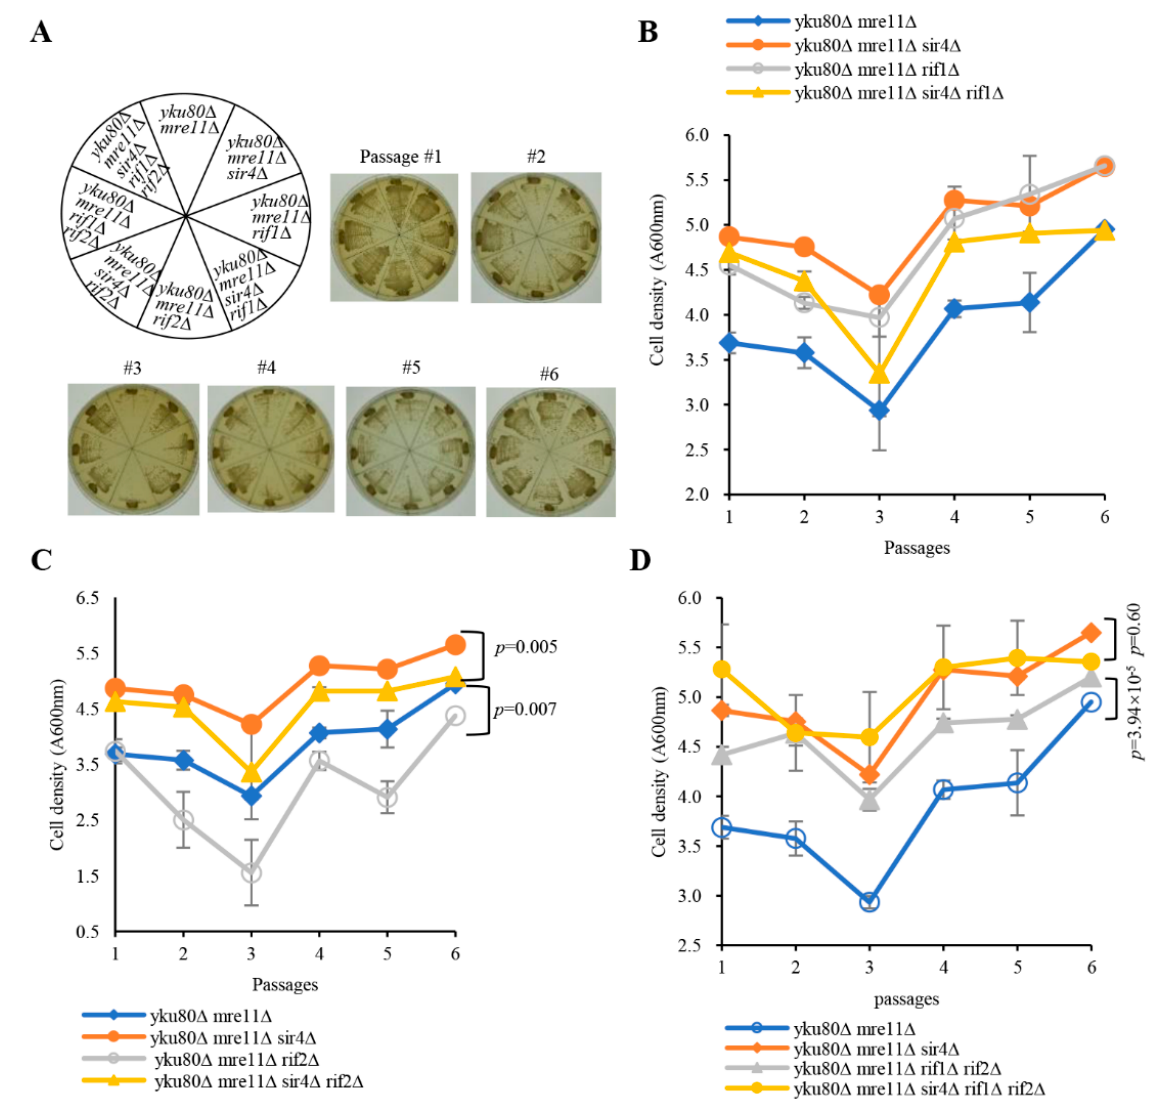
Figure 2. Effects of single and double deletions of RIF1 and RIF2 on the senescence of yku80 ∆ mre11 ∆ and yku80 ∆ mre11 ∆ sir4 ∆ cells. ( A ) Spore yku80 ∆ mre11 ∆ , yku80 ∆ mre11 ∆ sir4 ∆ , yku80 ∆ mre11 ∆ rif1 ∆ , yku80 ∆ mre11 ∆ sir4 ∆ rif1 ∆ , yku80 ∆ mre11 ∆ rif2 ∆ , yku80 ∆ mre11 ∆ sir4 ∆ rif2 ∆ , yku80 ∆ mre11 ∆ rif1 ∆ rif2 ∆ , yku80 ∆ mre11 ∆ sir4 ∆ rif1 ∆ rif2 ∆ were successively streaked on YPD plates every 2 days for six times. Images of photographed colony growth are from one of 4–5 typical experiments. ( B ) Spores yku80 ∆ mre11 ∆ , yku80 ∆ mre11 ∆ sir4 ∆ , yku80 ∆ mre11 ∆ rif1 ∆ , and yku80 ∆ mre11 ∆ sir4 ∆ rif1 ∆ cells. ( C ) yku80 ∆ mre11 ∆ , yku80 ∆ mre11 ∆ sir4 ∆ , yku80 ∆ mre11 ∆ rif2 ∆ , and yku80 ∆ mre11 ∆ sir4 ∆ rif2 ∆ . ( D ) yku80 ∆ mre11 ∆ , yku80 ∆ mre11 ∆ sir4 ∆ , yku80 ∆ mre11 ∆ rif1 ∆ rif2 ∆ , and yku80 ∆ mre11 ∆ sir4 ∆ rif1 ∆ rif2 ∆ cells were cultured in liquid YPD medium with initial concentration of A600 nm = 0.01 for around 20 h and followed by A600 nm measurement, and re-dilution was made every 20 h. Results are mean ± SEM ( n = 4–5).